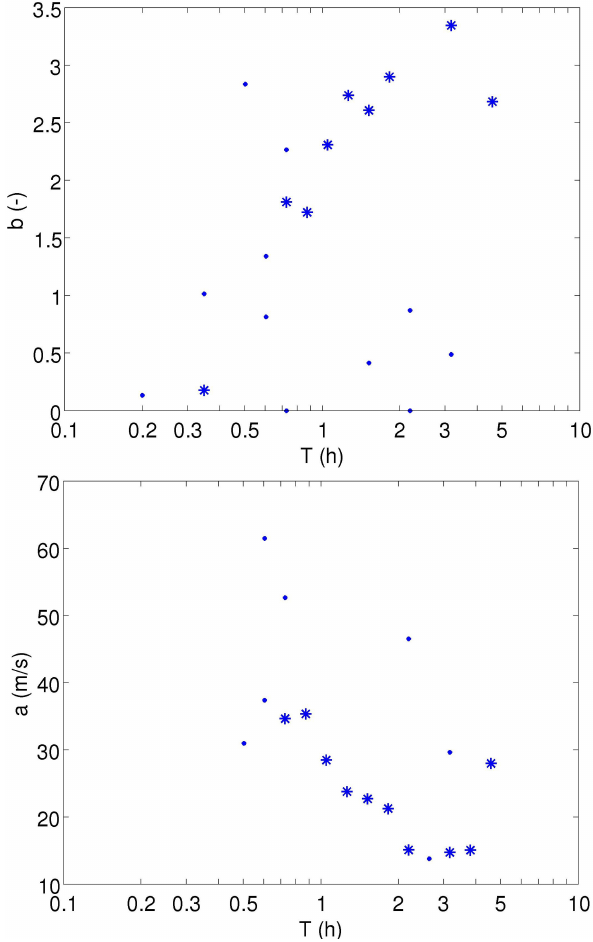
Figure 6. The slope b and offset a of the phase velocity profiles as found from the data of the entire day, as functions of the period length T